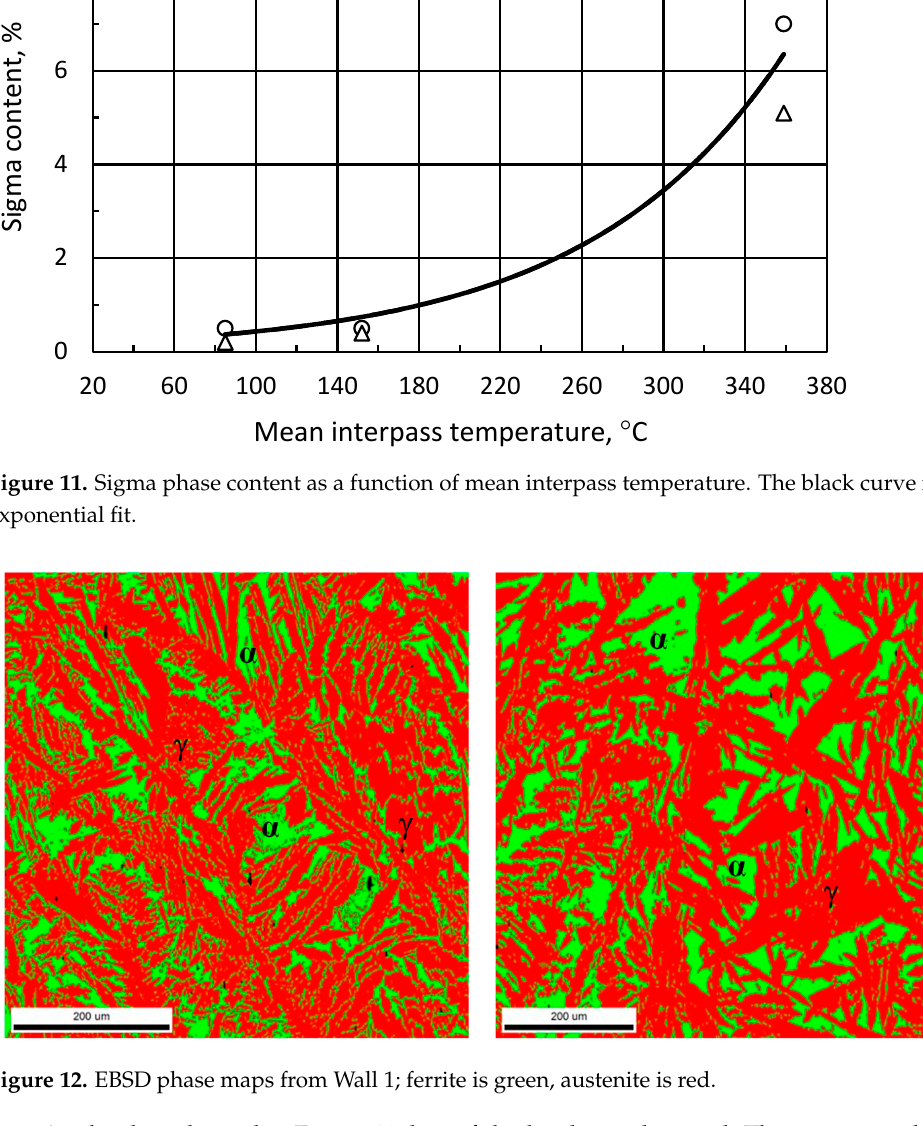
Figure 11. Sigma phase content as a function of mean interpass temperature. The black curve is an exponential fit.